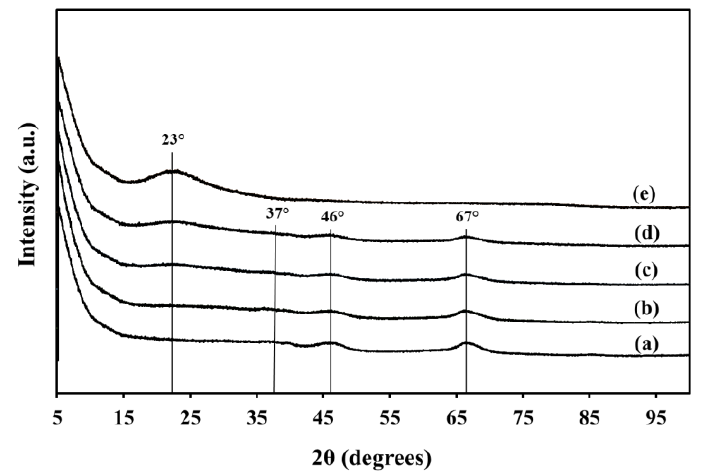
Figure 2. X-ray diffraction patterns of oxides calcined at 550 °C: ( a ) 100A, ( b ) 5SA, ( c ) 15SA, ( d ) 25SA y ( e ) 100S.